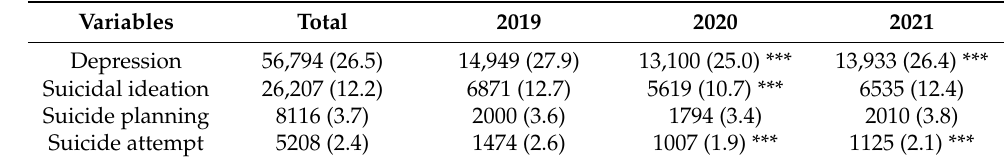
Table 2. Suicide-related characteristics from 2019 to 2021. n